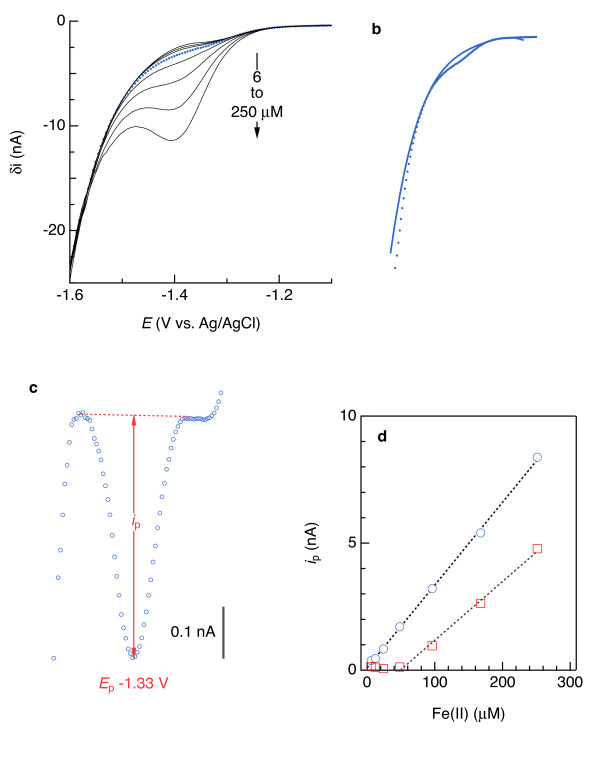
 (a) Current (i) versus potential (E) relationships for Fe(II) in artificial seawater containing 0.85 (mg C)/L as Pacific Ocean fulvic acid in square-wave mode, where δiis difference between the forward pulse currentiatE– 25 mV and reverse pulse currentiatE + 25 mV. (b) 4th-order polynomial baseline fit (solid line; δi = −1.77631·10-6 – 5.65237·10-6E – 6.75637-6E2 – 3.59825·10-6E3 – 7.21311 ·10-7E4) to 12 μM Fe(II). (c) Plot of peak current (ip) due to Fe(II) reduction obtained by baseline subtraction. (d) Calibration curves: blue symbols represent data obtained by 4th-order polynomial subtraction, ip = 0.0326(9)·[Fe(II)] + 0.1(1), with numbers in parentheses indicating the 90% confidence interval in the last digit and square brackets denoting concentration in μM; R2 = 0.9996; red symbols represent data obtained from linear baseline subtractions.